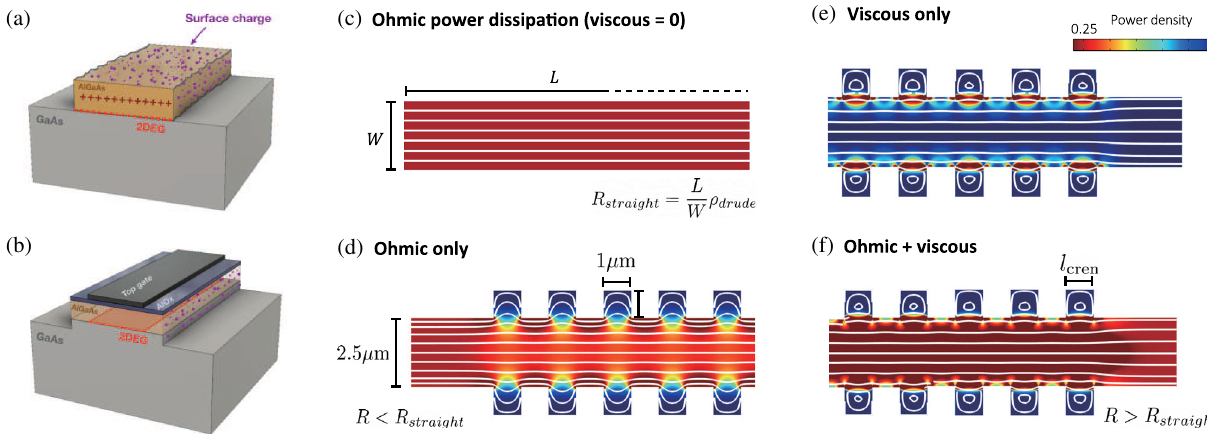
FIG. 1. (a),(b) 3D schematics showing (a) a conventional modulation-doped GaAs = Al Ga 1 − As heterostructure. The conduction x x channel is patterned using chemical etching, which causes rough sidewalls, while random surface charge on the sidewalls creates additional disorder. (b) An accumulation-mode GaAs = Al Ga 1 − As device. The channel is defined by a metal top gate and kept away x x from etched sidewalls and surface charge. (c) – (f) Theoretical simulations (see the Appendix D) of the power dissipation density ( W=m 2 ) under the perfect slip boundary condition (width W ¼ 2 . 5 μ m, length L ¼ 25 μ m) in the linear response regime (Reynolds number much smaller than 1). The color scale represents the magnitude of the dissipation, and white lines show the electron flow streamlines. (c) Power dissipation density of a straight channel. The dissipation is purely Ohmic, as viscous contribution vanishes with perfect slip ¼ 1 μ m) with zero viscosity, i.e., boundaries. (d) Ohmic power dissipation density of a crenellated channel (crenellation size l cren nonviscous electron transport. The Ohmic resistance of the crenellated channel is smaller than the straight channel. (e) Viscous power dissipation density of the crenellated channel with a viscosity of ν ¼ 1 . 15 × 10 − 2 m 2 = s. The viscous power dissipation density concentrates around the regions where the streamlines deform the most to form slow whirlpools in the crenellations [19]. The viscous power dissipation vanishes near the boundaries due to the perfect slip boundary condition. (f) Total power dissipation density of the crenellated channel for a viscous electron flow summing up both Ohmic and viscous